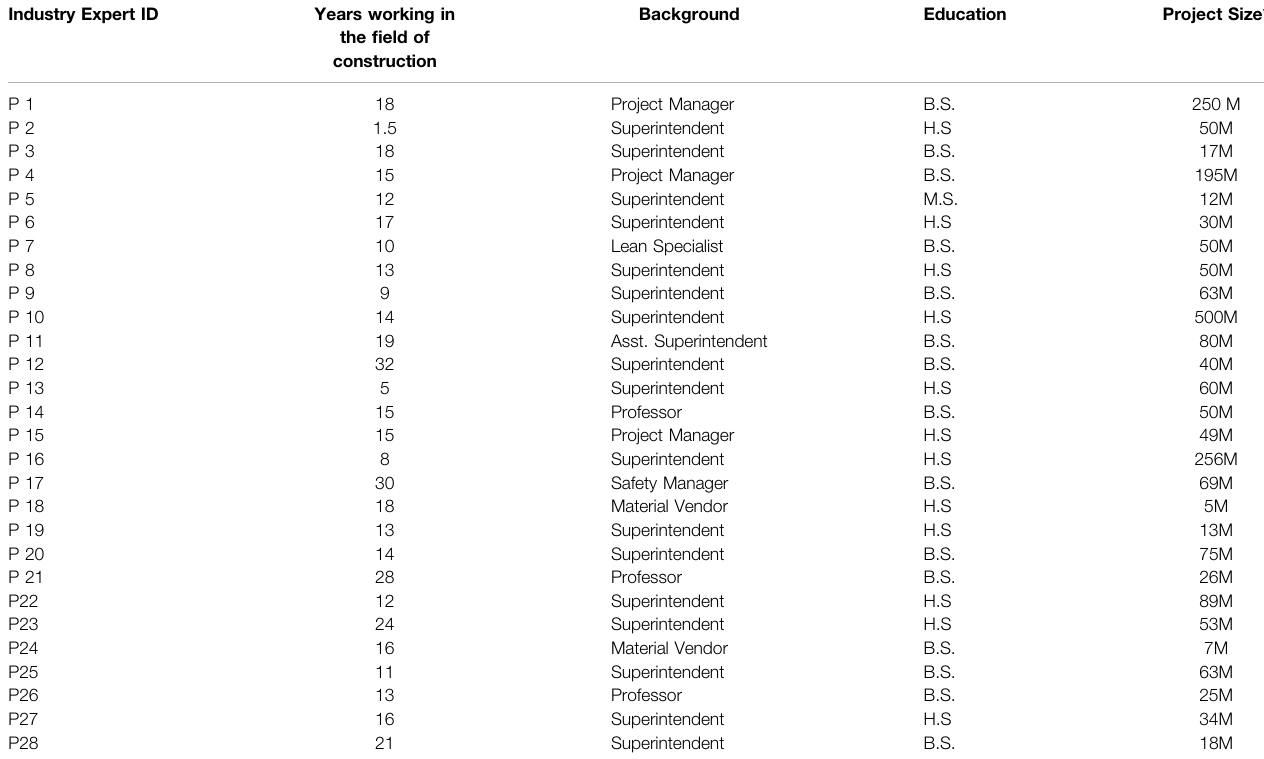
TABLE 3 | Industry Expert Characteristics. Industry Expert ID Years working in